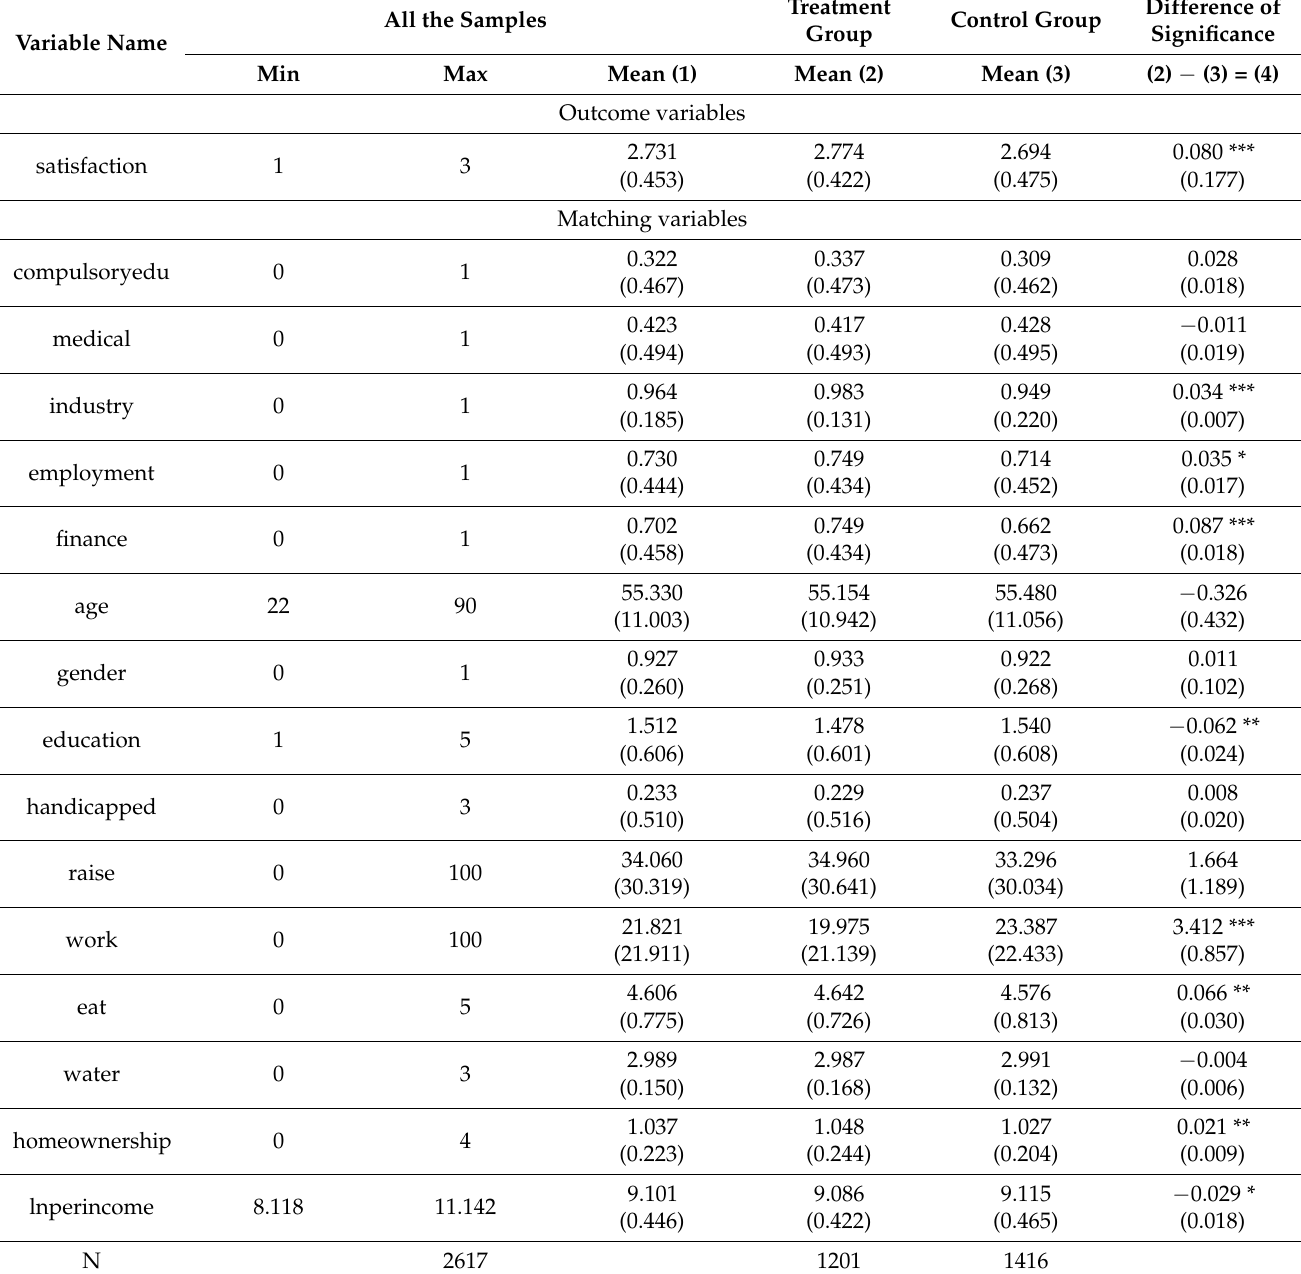
Table 4. Descriptive statistics of the main